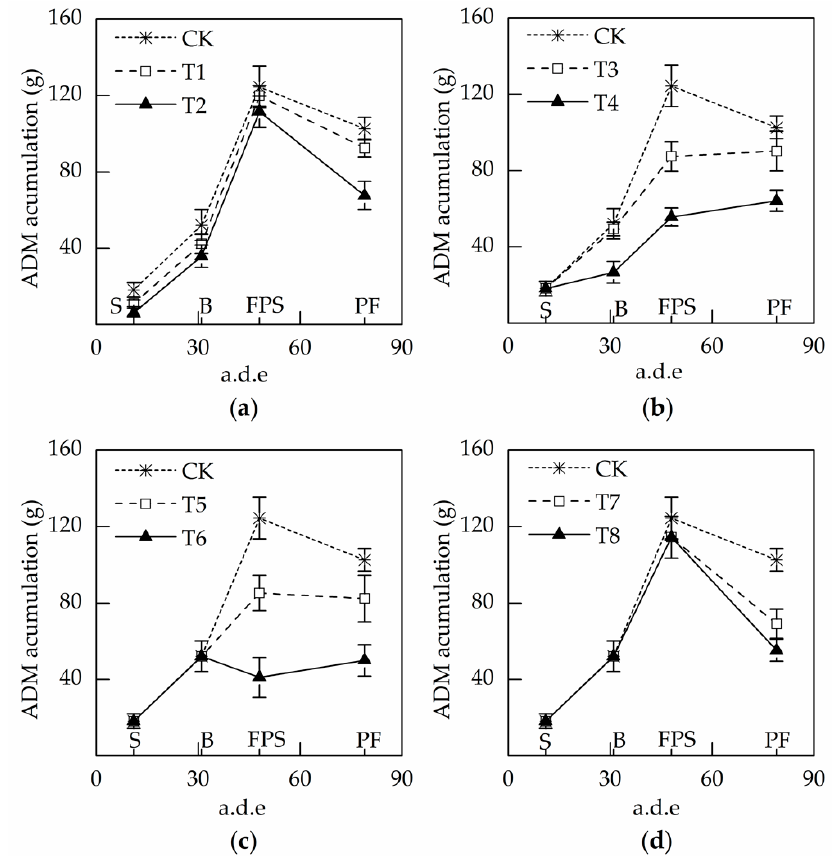
Figure 4. Aboveground dry matter accumulation (ADM) of soybean during different growth stages under water stress in 2015: ( a – d ) the treatments with drought stress during seedling, branching, flowering and pod-setting stage, and pod-filling stage. S, seedling stage; B, branching stage; FPS, flowering and pod-setting stage; PF, pod-filling stage; d.a.e, day after emergence. Values were averaged from five samples.